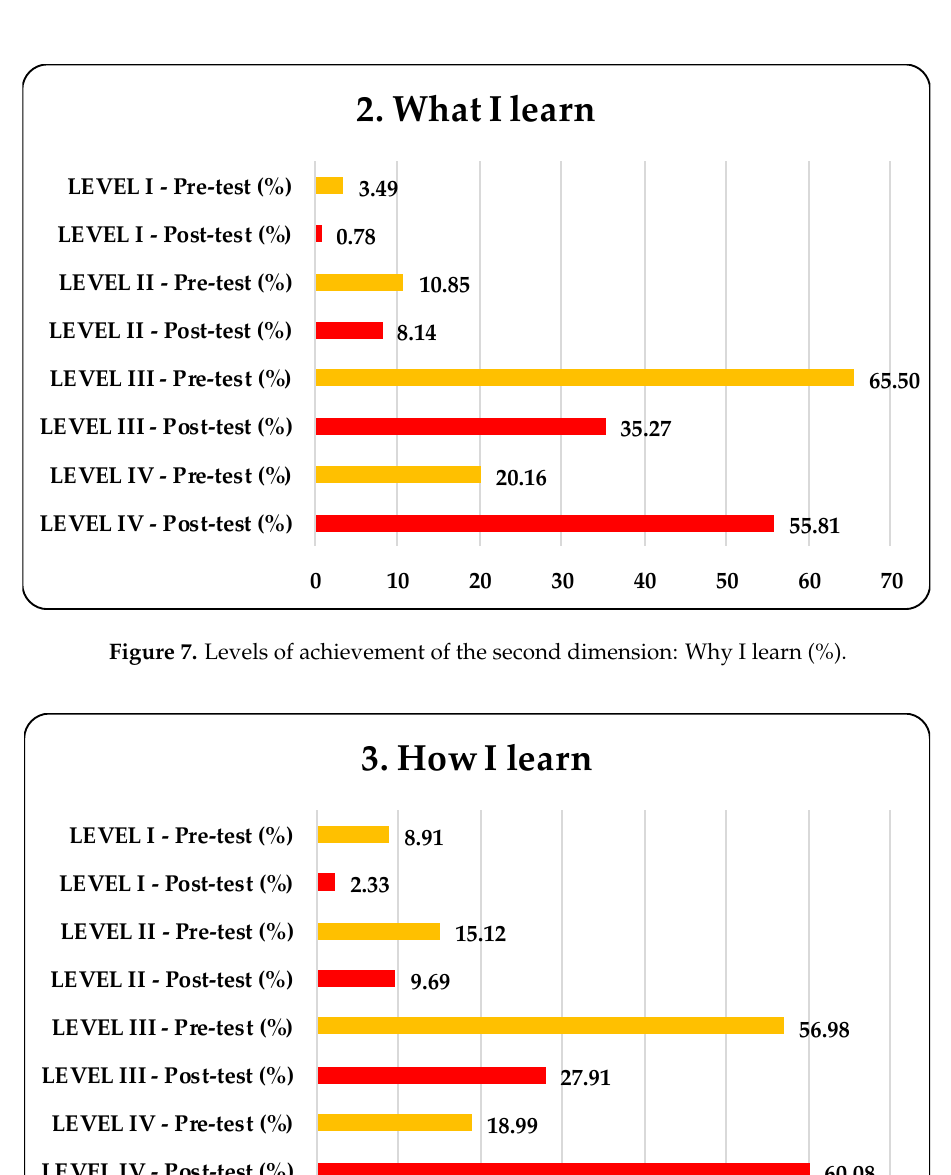
Figure 6. Levels of achievement of the first dimension: Why I learn.